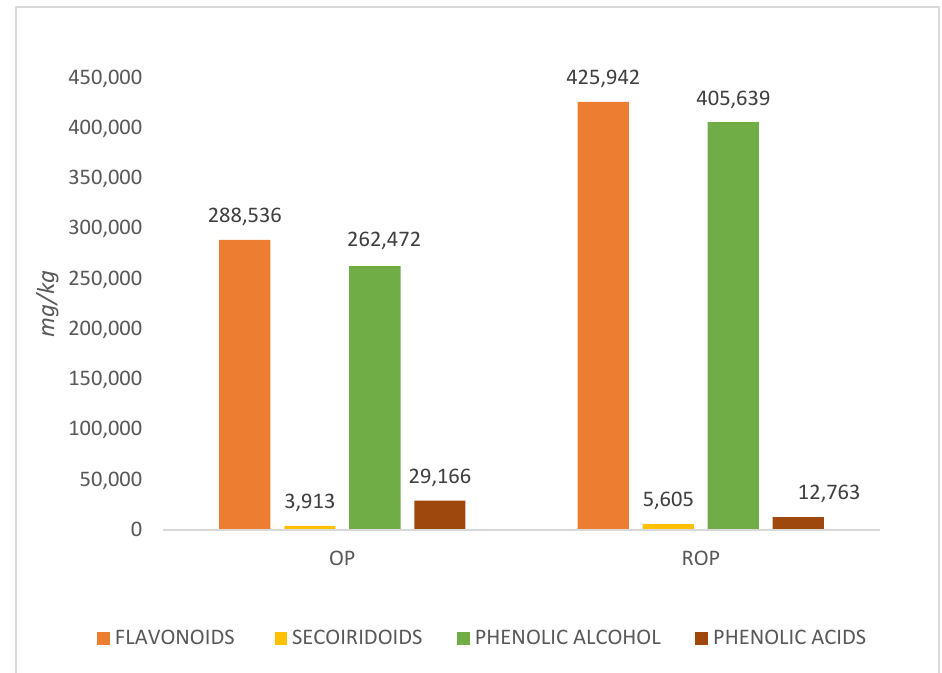
Figure 2. Total concentration of each class of phenolic compounds.